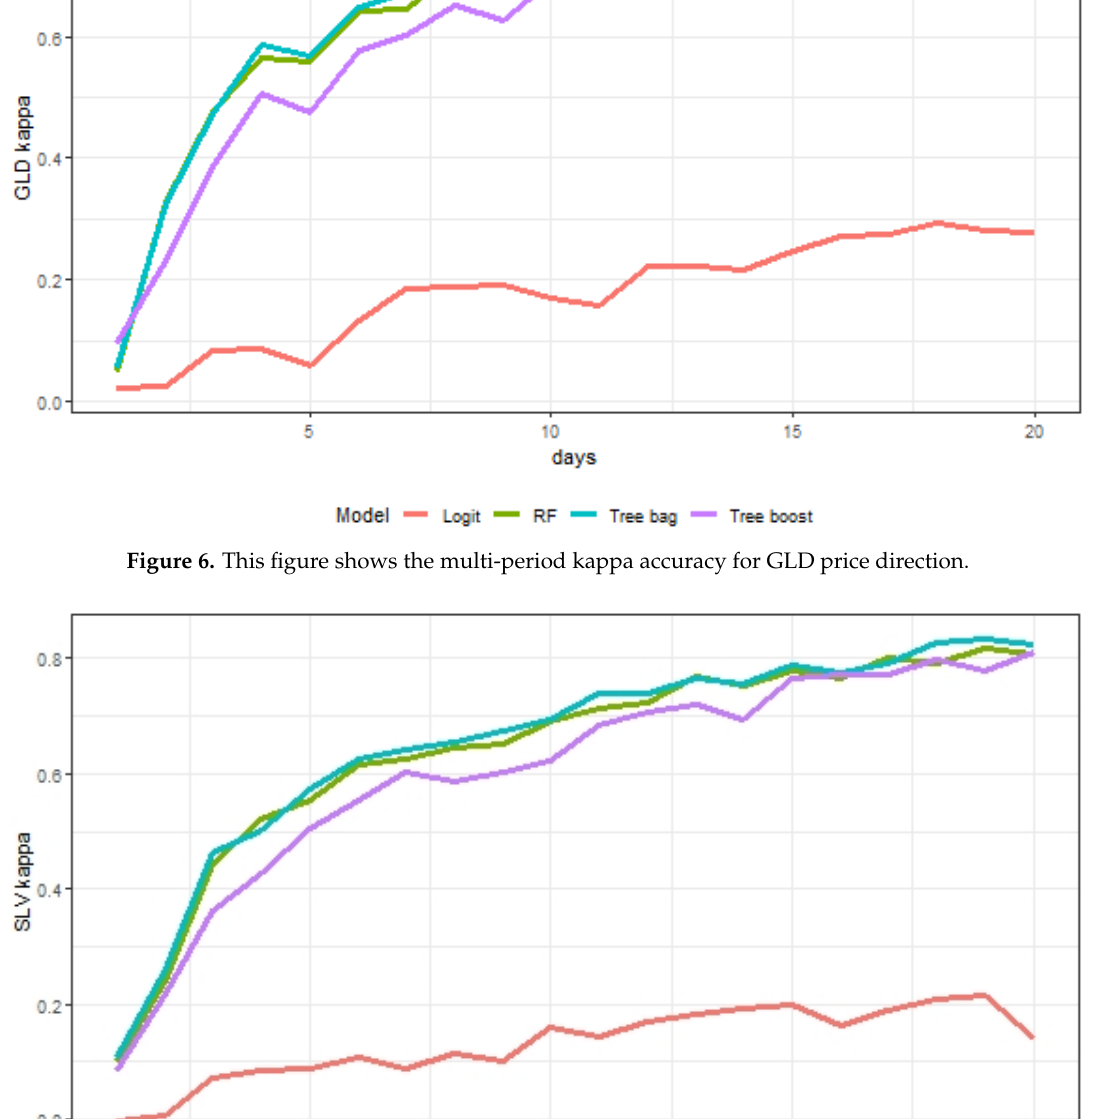
Figure 5. This figure shows the multi-period prediction accuracy for SLV price direction.